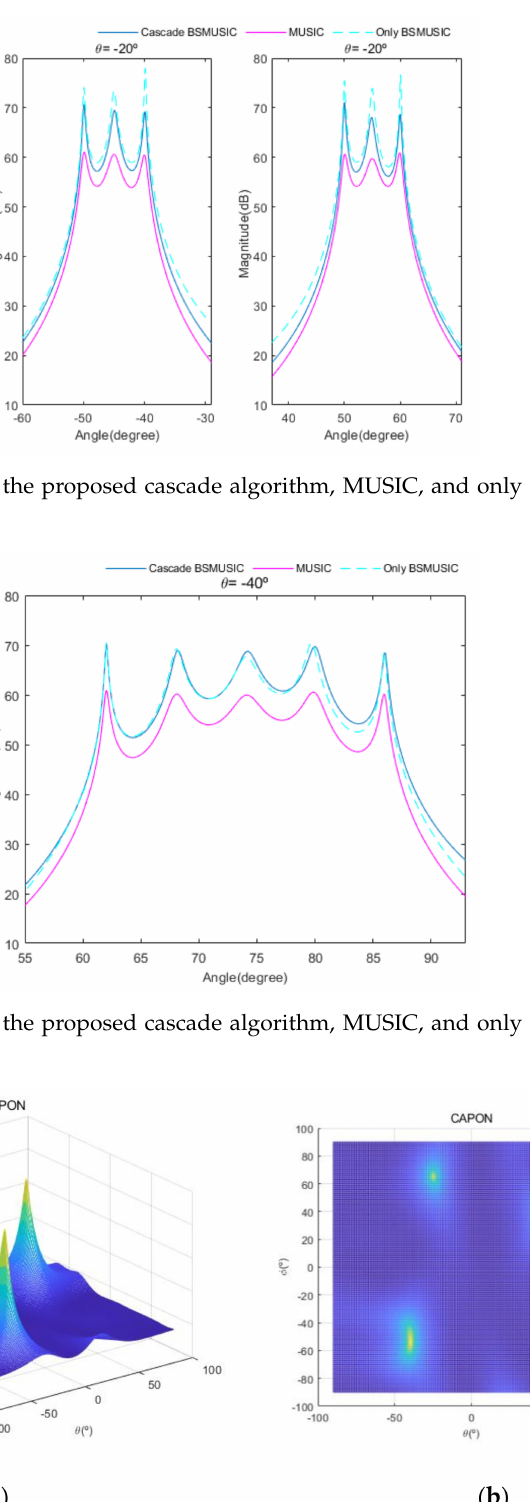
Figure 16. Spatial spectrum of CAPON for the fourth scenario: ( a ) 3D plot, ( b ) top view ( θ = − 90 ◦ ∼ 90 ◦ , φ = − 90 ◦ ∼ 90 ◦